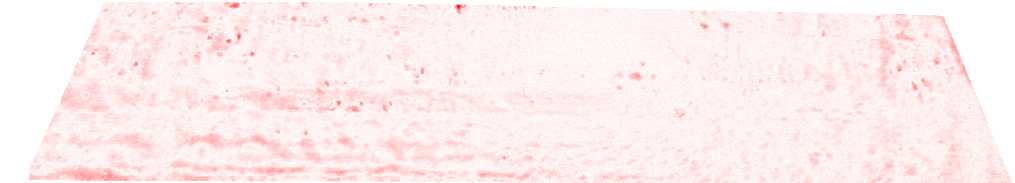
Figure 17. Second inspection at Water dam